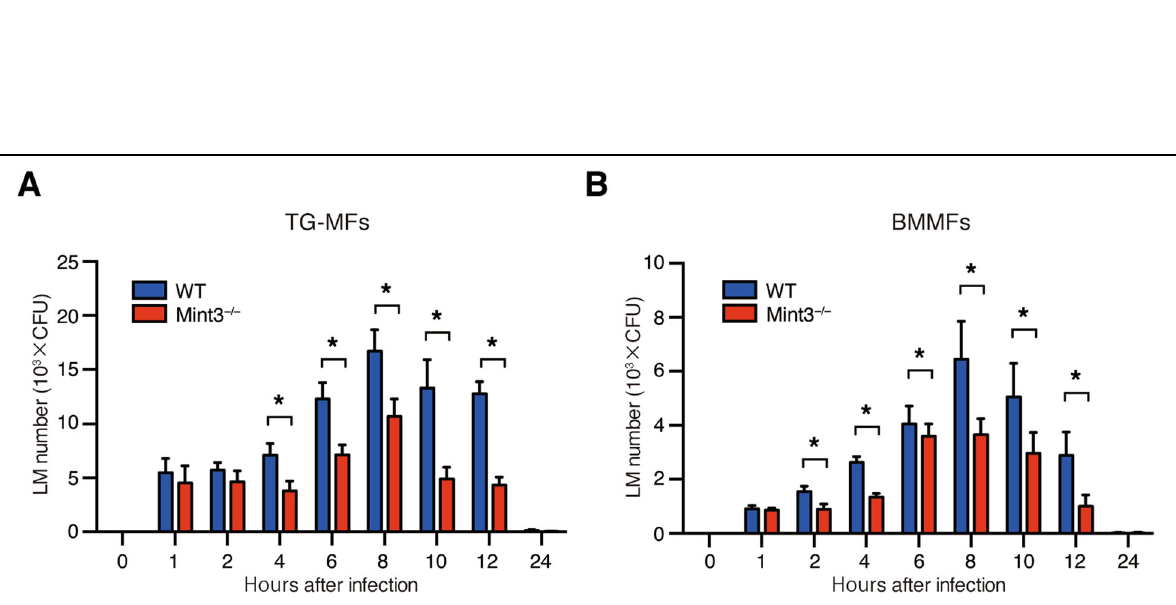
Fig. 1 Loss of Mint3 attenuates severe listeriosis. A Survival rates of mice following infection with Listeria monocytogenes (LM). Both WT and Mint3 – / – mice ( n = 18 per group) were infected via intraperitoneal injection of 2 × 10 5 colony-forming units (CFUs) of LM, followed by the assessment of survival rates. Data are representative of two independent experiments. * P < 0.05 by the log-rank test. B Bacterial burdens in the spleen and C liver, counted on days 1, 3, and 7 after LM infection. D IL-1 β and E IL-18 production in the peritoneal cavities of WT and Mint3 – / – mice. Data are presented as the means ± SEMs and are representative of two independent experiments. * P < 0.05 by the Mann – Whitney U